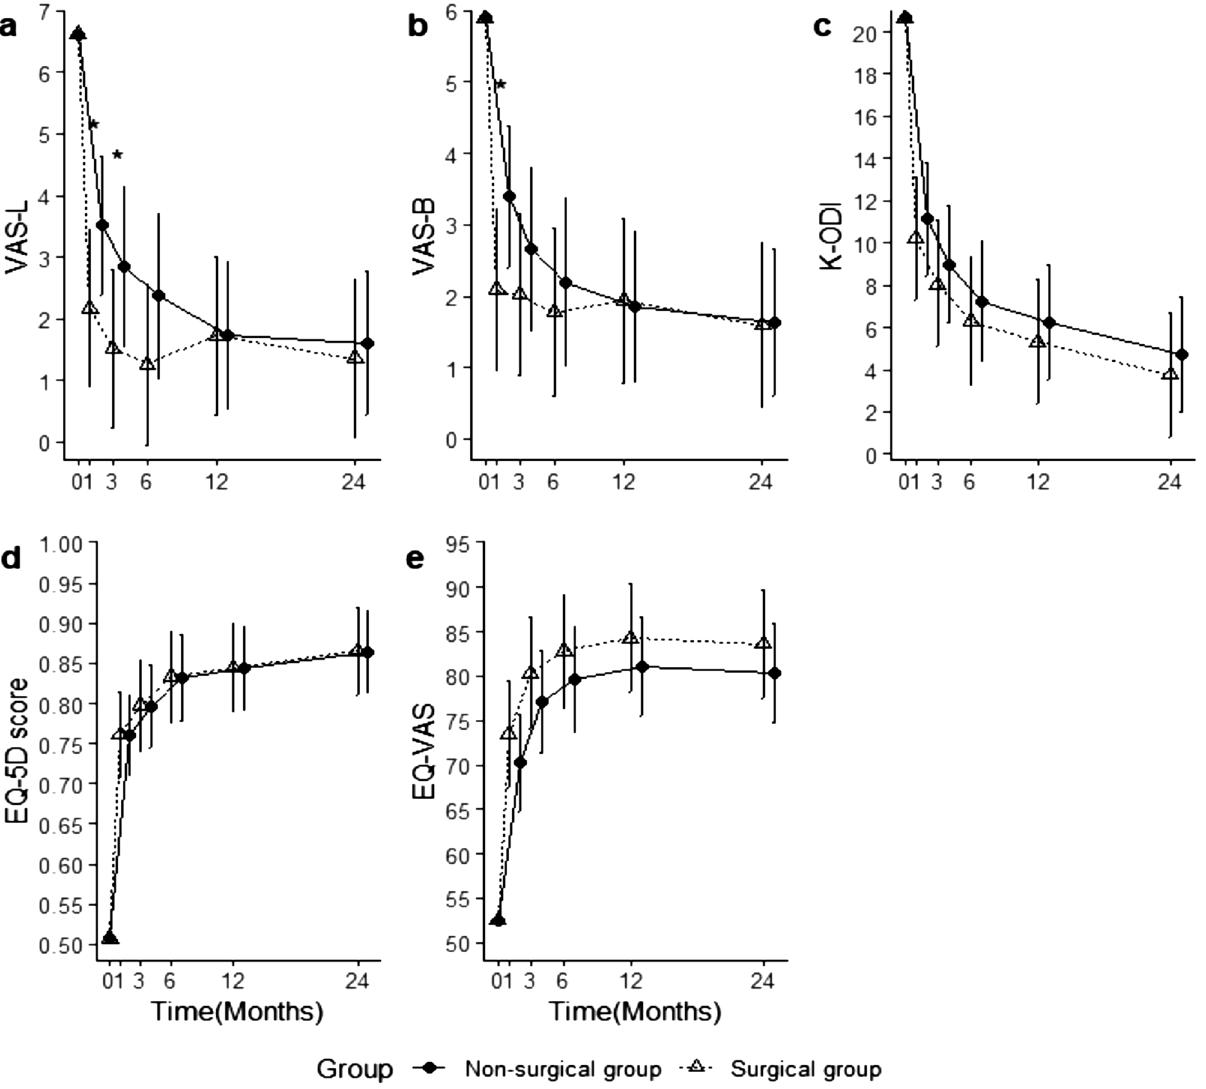
Figure 3. Clinical outcomes. The adjusted means and confidence intervals estimated from mixed effect models for the clinical outcomes; ( a ) Visual analogue scale for leg pain (VAS-L), ( b ) Visual analogue scale for back pain (VAS-B), ( c ) Korean version of the Oswestry Disability Index (K-ODI), ( d ) The EuroQol 5-Dimension utility score (EQ-5D score), ( e ) The EuroQol visual analogue scale (EQ-5D VAS). Asterisks (*) indicate significant differences between